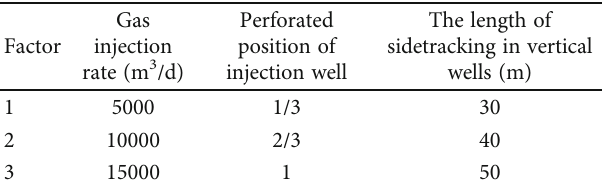
Figure 7: Relationship between vertical sidetrack length and recovery factor. Table 2: Value level of development engineering